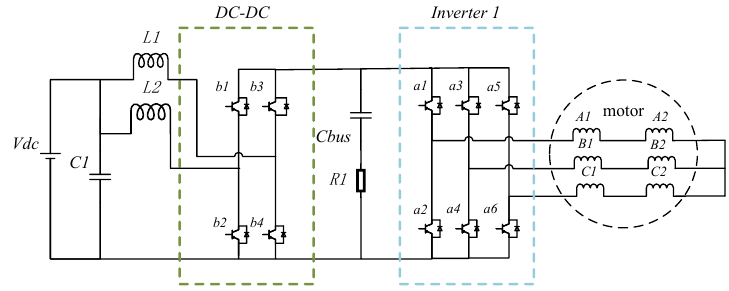
Figure 2. Structure of the PMSM with DC-DC converter